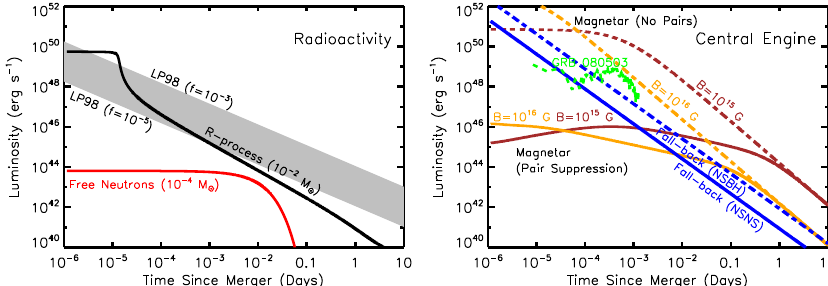
Fig.2 Luminosityversustimeafterthemergerofarangeofheatingsourcesrelevanttopoweringkilonovae. Left sources of radioactive heating include the decay of ∼ 10 − 2 M (cid:4) of r-process nuclei, as first modeled in a parameterized way by Li and Paczy´nski (1998) (Eq. 2, grey band ) and then more accurately by Metzger et al. (2010b), plotted here using the analytic fit of Korobkin et al. (2012) (Eq. 22, black line ) and applying the thermalization efficiency of Barnes et al. (2016) (Eq. 23). The outer layers of the merger ejecta may contain 10 − 4 M (cid:4) free neutrons ( red line ), which due to their anomalously long half-life produce significant heating on a timescale of tens of minutes if they exist in the ejecta (Sect. 4.1.3). Right sources of central engine heating. These include fall-back accretion ( blue lines ), shown separately for the case of a NS–NS merger ( solid line ) and BH–NS merger ( dashed line ), based on the SPH simulations of Rosswog (2007) for an assumed jet efficiency (cid:10) j = 0 . 1 (Eq. 30). Also shown is the energy input due to the spin-down of a stable central magnetar remnant with an initial spin period of P = 0 . 7 ms dipole field strengths of B = 10 15 G ( brown lines ) and B = 10 16 G ( orange lines ). We show separately the total spin-down luminosity L sd ( dashedlines ;Eq.32),aswellastheeffectiveluminosityaccountingalsoforthesuppression ofthermalizationofthemagnetarenergybythehighopacityof e ± pairsinthenebula( solidlines ;seeEq.35 and surrounding discussion; Metzger and Piro 2014). The isotropic X-ray luminosity of the extended emission following the short GRB 080503 is shown with a green line for an assumed redshift z = 0 . 3 (Perley et al. 2009; see also bottom panel of Fig.